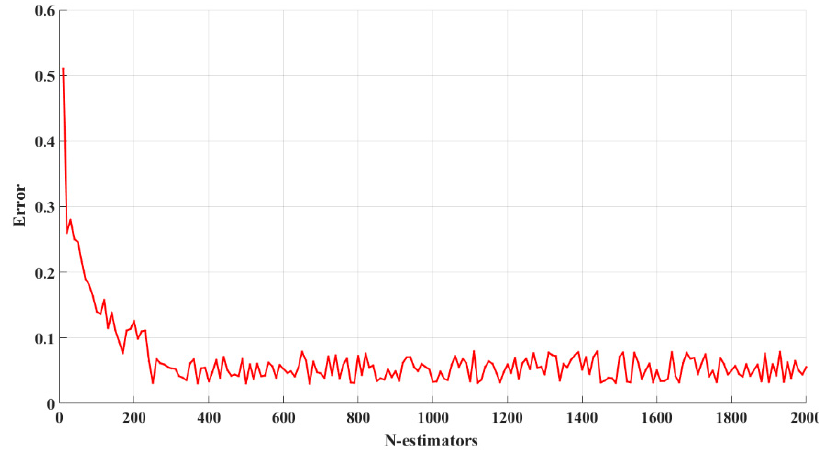
Figure 7. The influence of the estimator on the performance of the model.